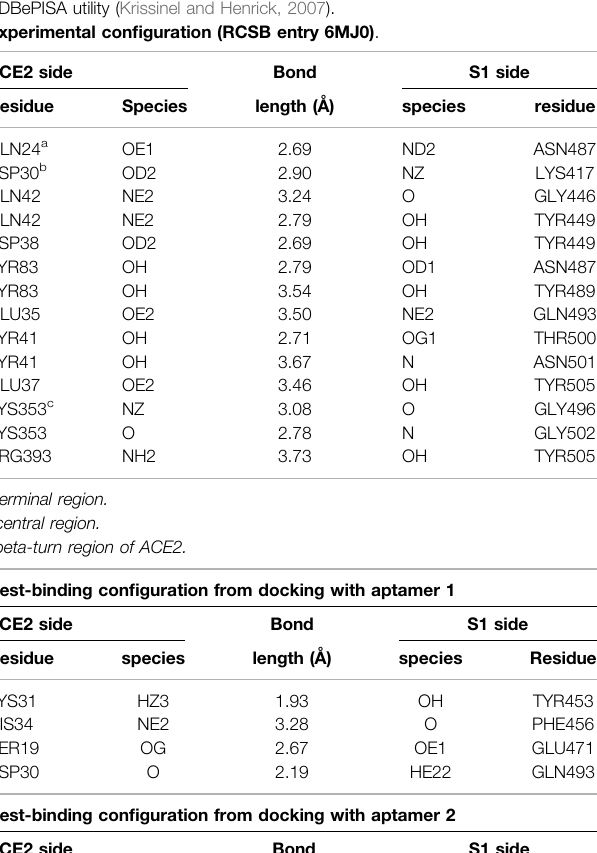
TABLE 1 | Hydrogen bonds formed at the ACE2-S1 interface in the crystallographic experimental con fi guration (RCSB entry 6MJ0 (Lan et al., 2020), and in the “ best binding ” con fi gurations from molecular dynamics simulations,startingwiththe apta1 or apta2 DNAaptamersdockedtoS1.Donor/ acceptor species are labelled according to the AMBER99 atom codes (Ponder and Case, 2003); molecular structure data analysed by